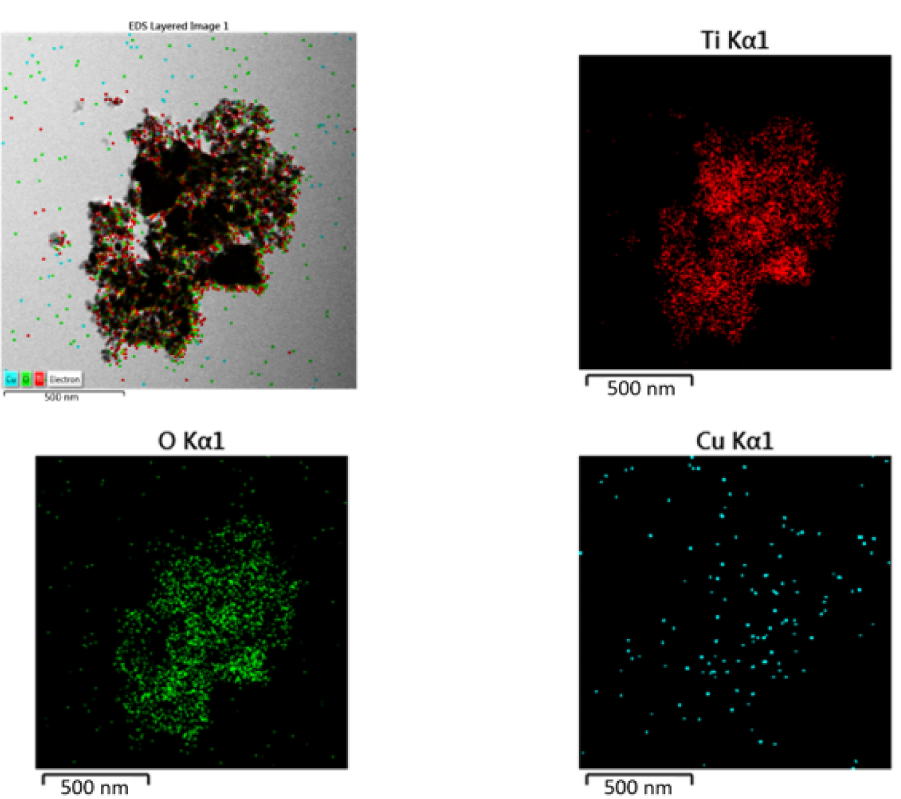
Figure 5. EDS element mapping image of Cu/TiO 2